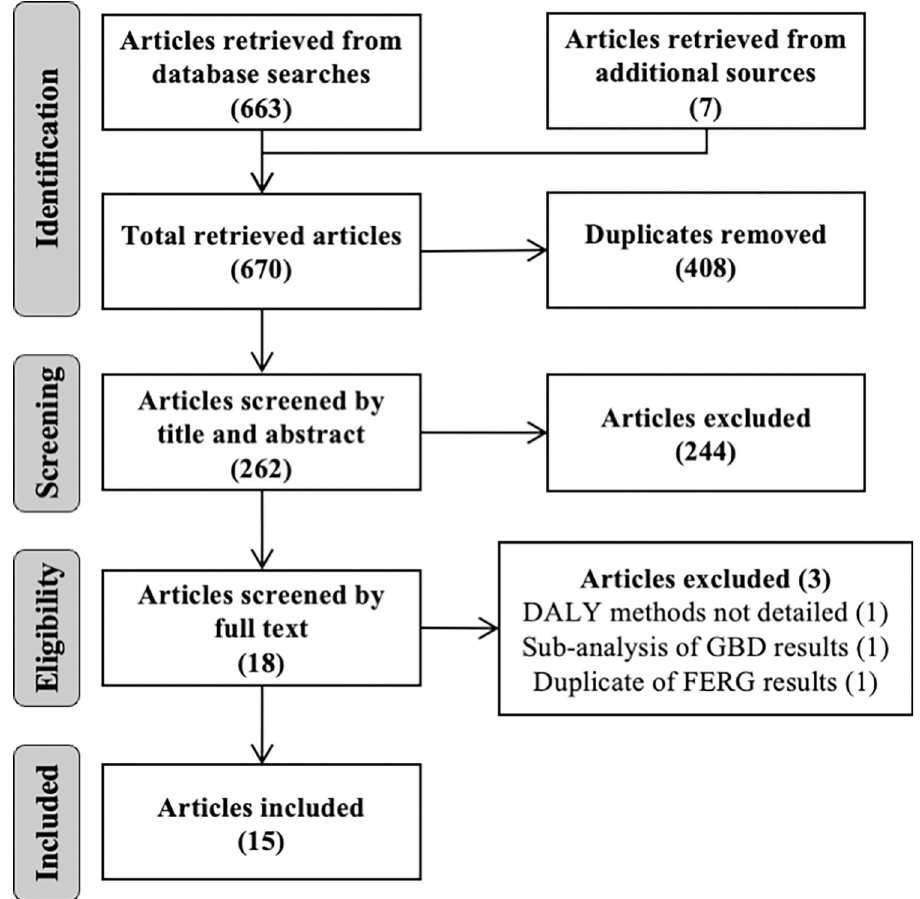
Fig 1. Flow diagram of study